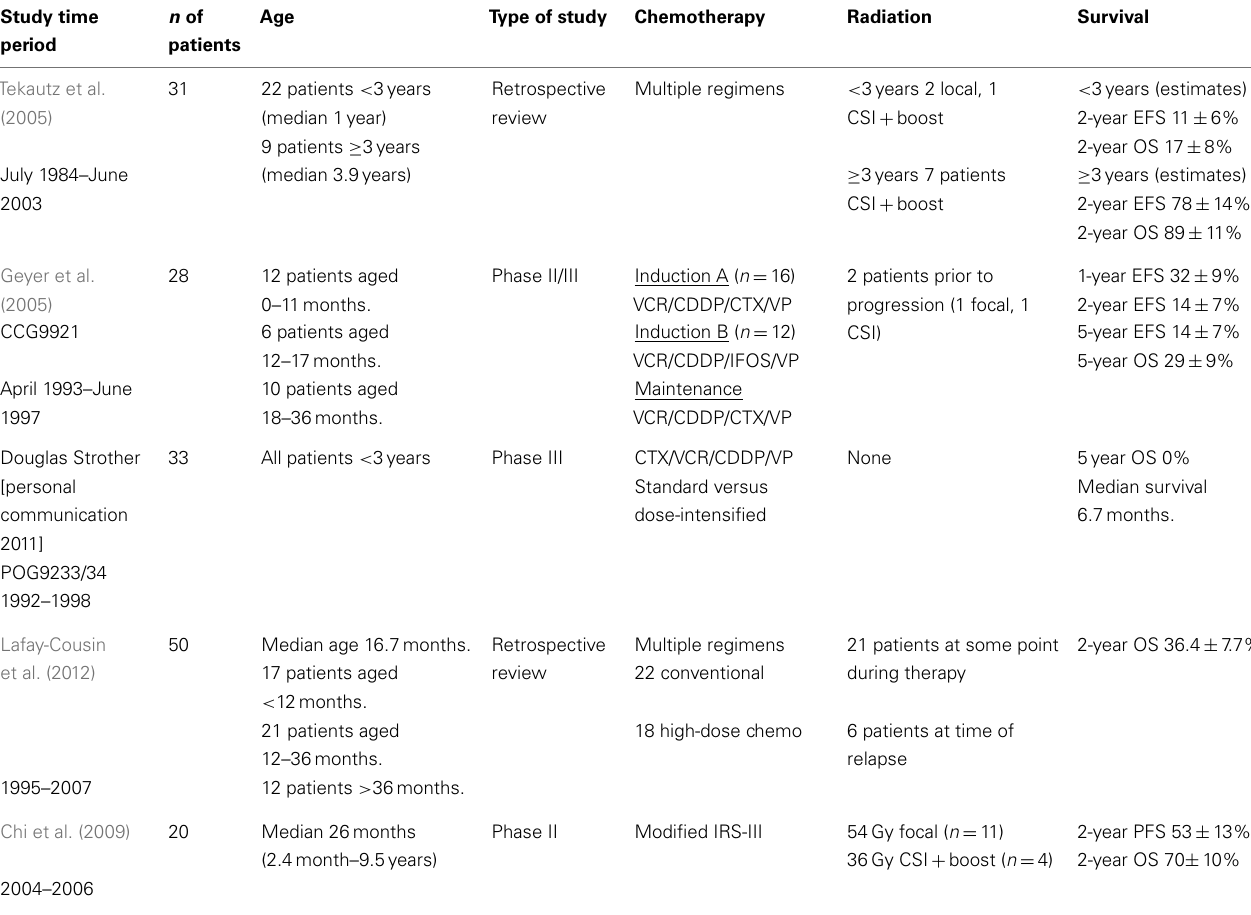
Table 1 | Published reviews and clinical trials that included or were specific to atypical teratoid rhabdoid tumors. Study time Type of study Radiation